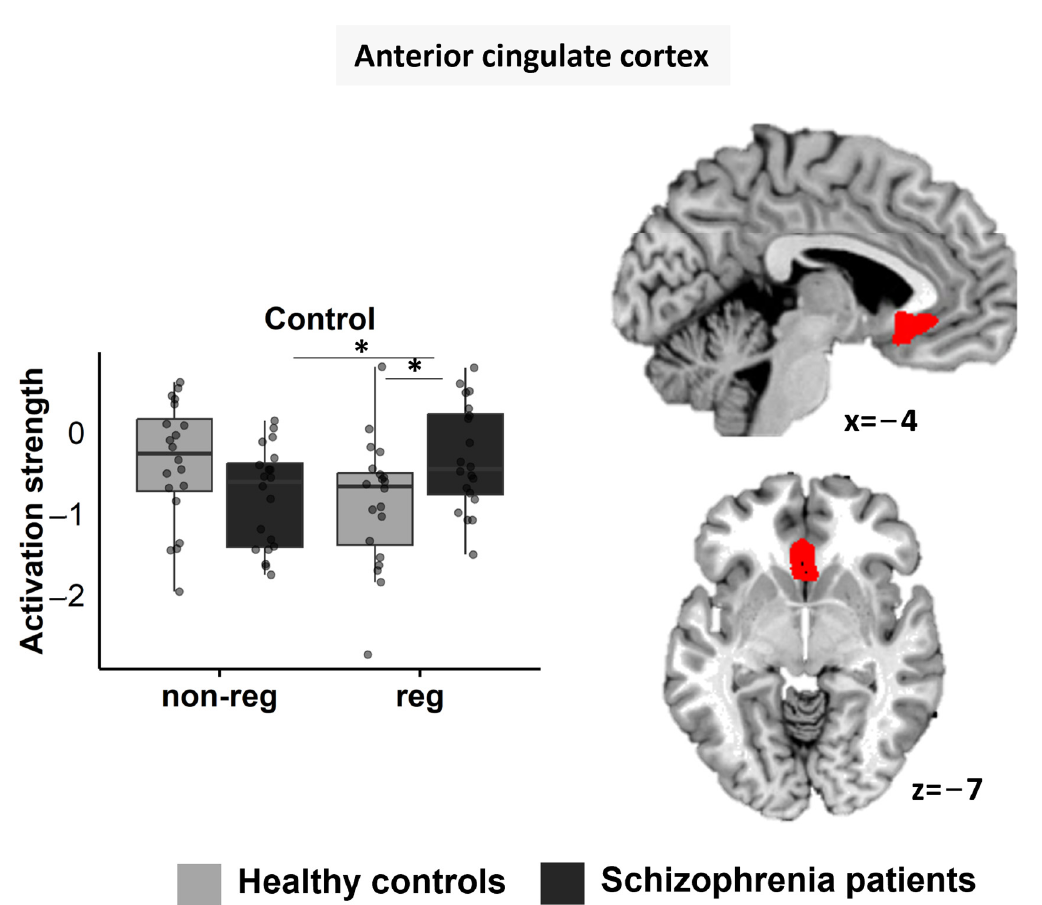
Figure 4. Region-of-interest analysis of the ventral ACC (red) showed a “regulation-by-condition-by-group” interaction. While no group differences emerged for the stress condition, SZP showed less deactivation compared to HC in the control condition in the regulation block. Additionally, in SZP, the ventral ACC was less deactivated in the control condition in the regulation block compared to the control condition in the non-regulation block. non-reg = non-regulation block; reg = regulation block. Significant differences are marked with *.